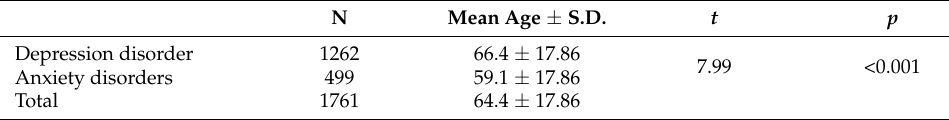
Table 3. Mean age of patients with depression/anxiety ( n = 3343).